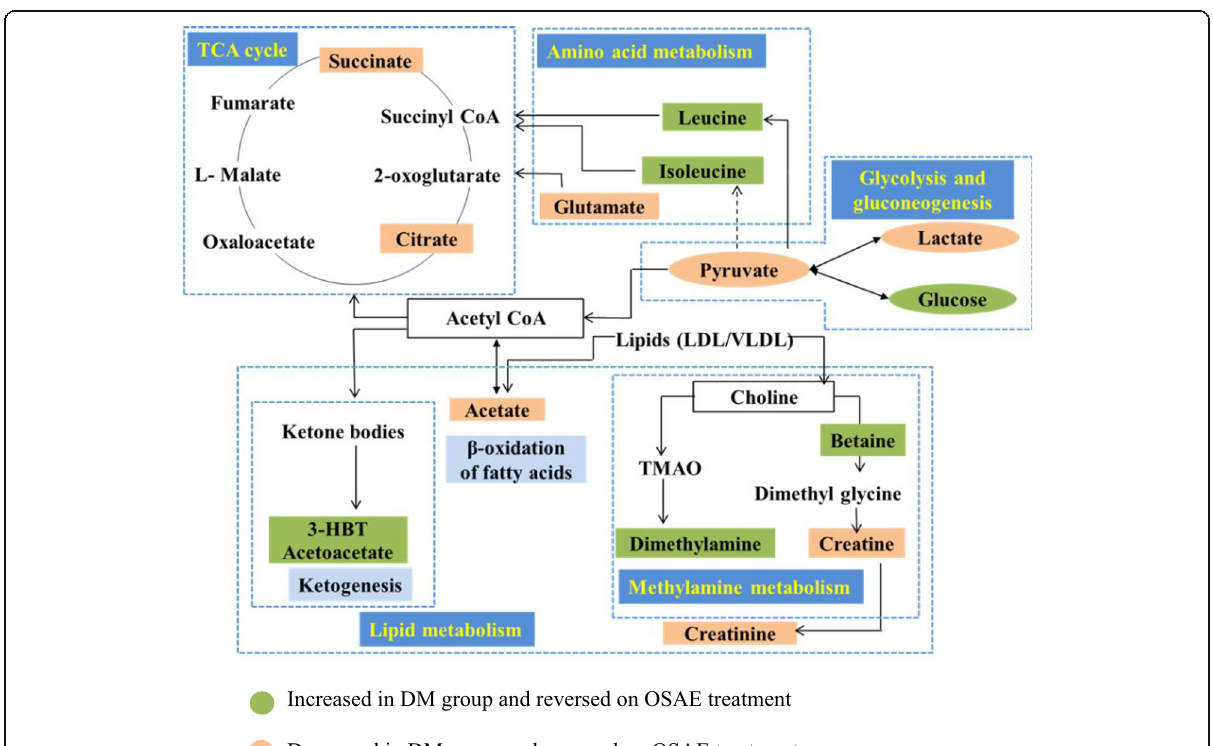
Fig. 8 Schematic representation depicting the interrelationships of the disturbed metabolic pathways identified by 1 H NMR urine